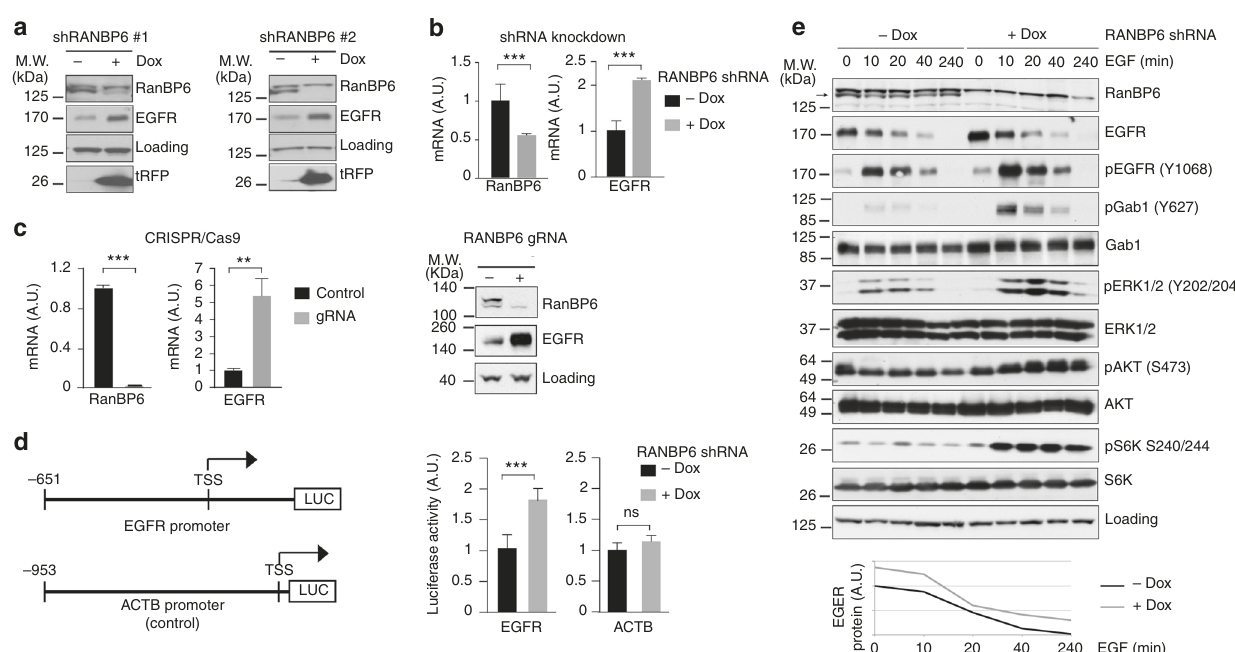
Fig. 2 RanBP6 regulates EGFR levels and EGFR signal output. a RanBP6 knockdown (KD) raises EGFR protein levels in HEK-293T cells. Dox doxycycline. b RanBP6 KD increases EGFR mRNA levels in HEK-293T cells. Shown are RT-qPCR results. c CRISPR/Cas9-mediated knockout of RanBP6 increases EGFR mRNA (left panel) and EGFR protein (right panel) levels in HEK-293T cells. d RanBP6 KD increases transcription of a luciferase reporter gene from EGFR promoter, but not from the β -actin ( ACTB ) promoter, in HEK-293T. e RanBP6 KD increases activation of the EGFR downstream signaling pathways and does not impair EGF-induced EGFR degradation in HEK-293T cells. Upper panel, immunoblot of whole-cell lysates serum starved for 16 h and then stimulated with EGF (100 ng/ml) for the indicated time points; Lower panel, densitometric analysis of EGFR. Data in bar graphs are represented as mean